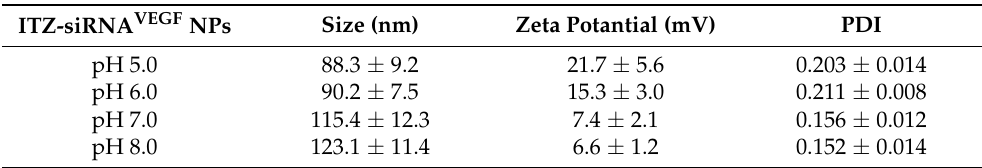
Table 1. Particle sizes and zeta potentials of ITZ-siRNA VEGF NPs at different pH values revealed pH-dependent attachment and detachment of PEG-PAsp under acidic